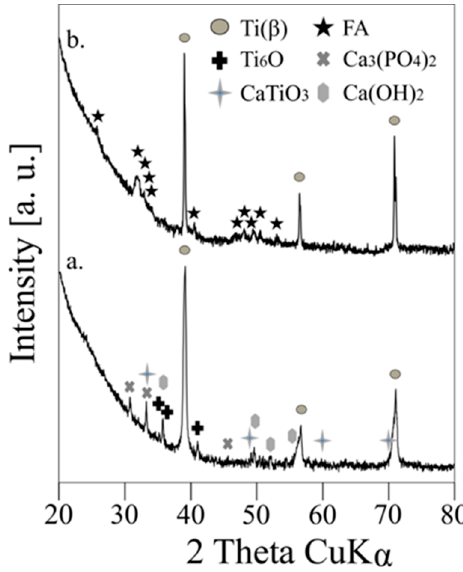
Figure 6. XRD spectra of Ti23Mo alloy MA for 48 h and cold-pressed and sintered at 800 °C/0.5 h and next surface-treated: MAO ( a ), MAO + EPD ( b ).